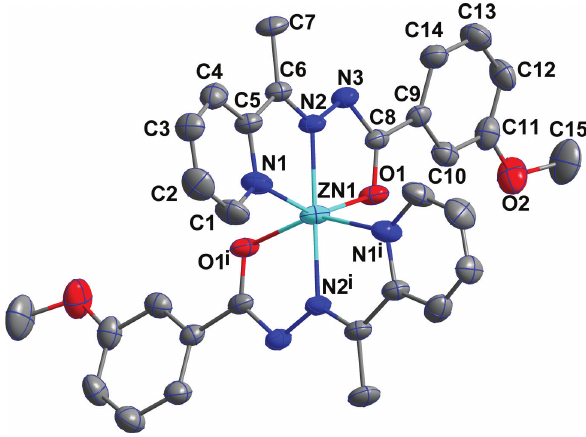
Table 2: Fractional atomic coordinates and isotropic or equivalent isotropic displacement parameters (Å 2